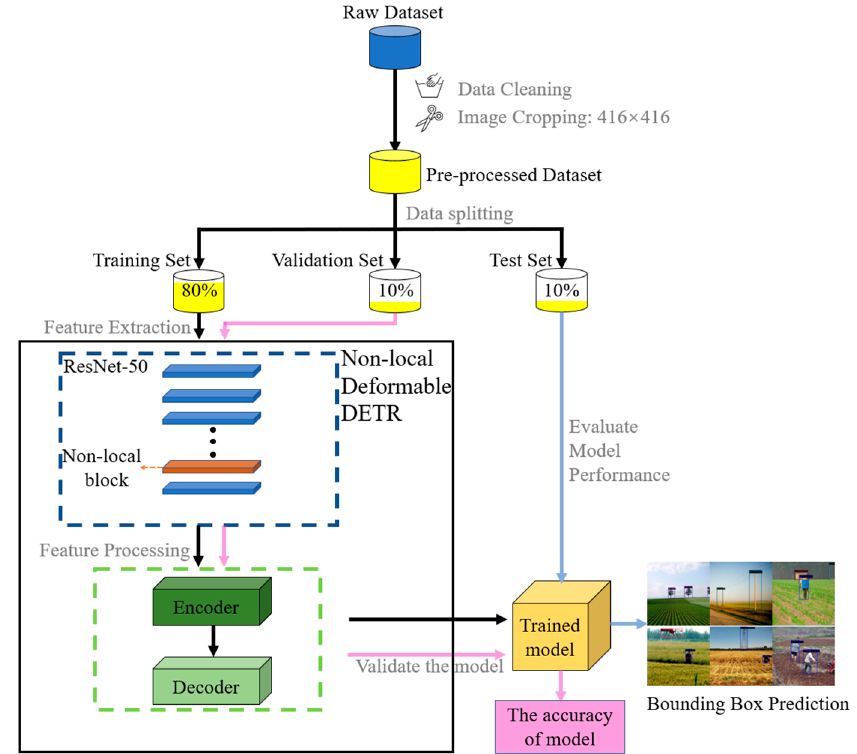
Figure 6. Overview of the data flow.